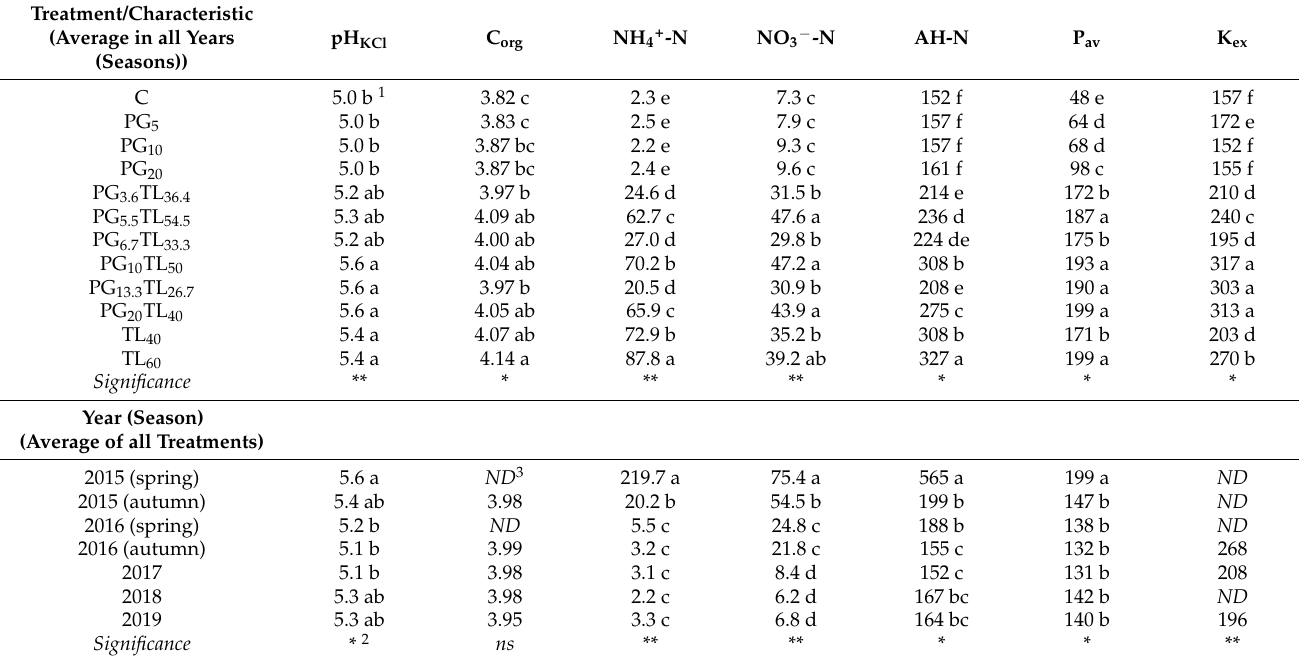
Table 15. Effect of treatments and years on soil agrochemical